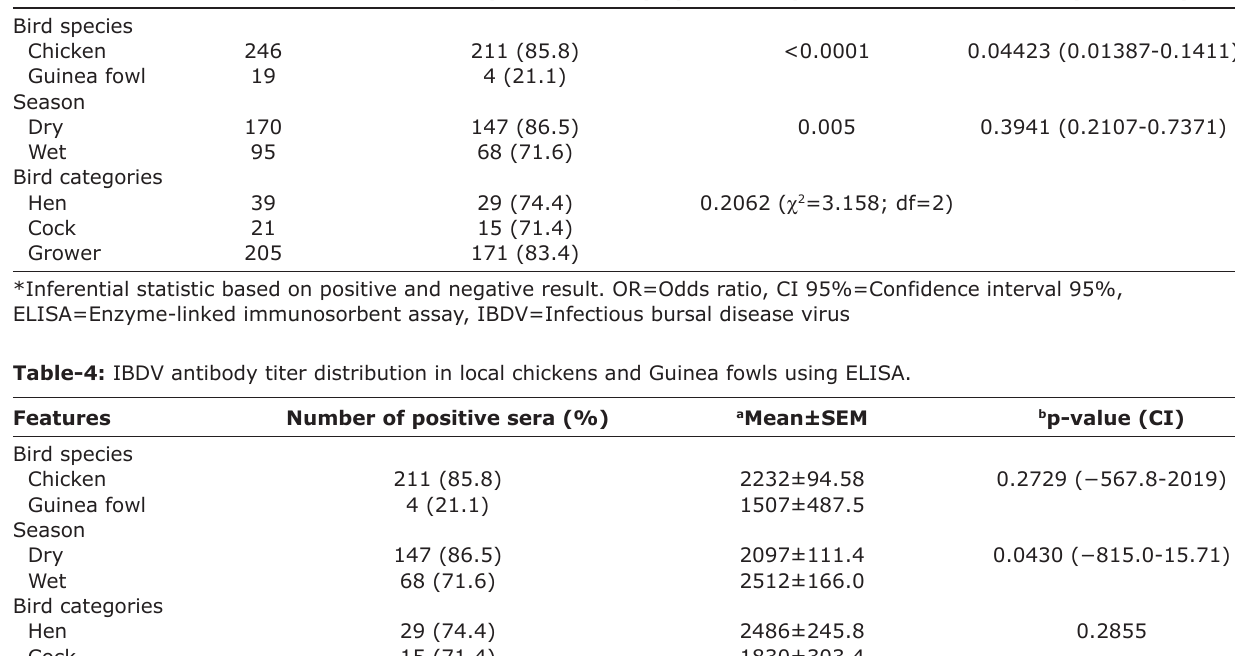
Table-3: Distribution and significance of IBDV antibody-positive birds using ELISA. Features